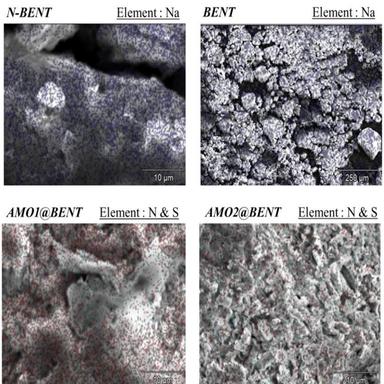
EDX mapping of Na (Purple color), N (Red color) and S (Green color) in N-BENT, BENT, AMO1@BENT and AMO2@BEN samples.